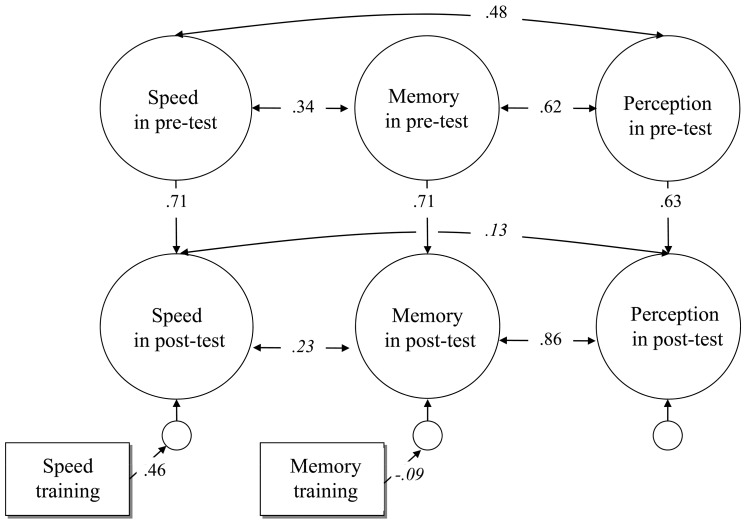
Omnibus model comprising pre- and post-test measurements for all three ability factors of face cognition with both training groups included as dummy variables.Unique scores were autocorrelated over time. Coefficients that did not reach statistical significance at α = .05 are italicized.